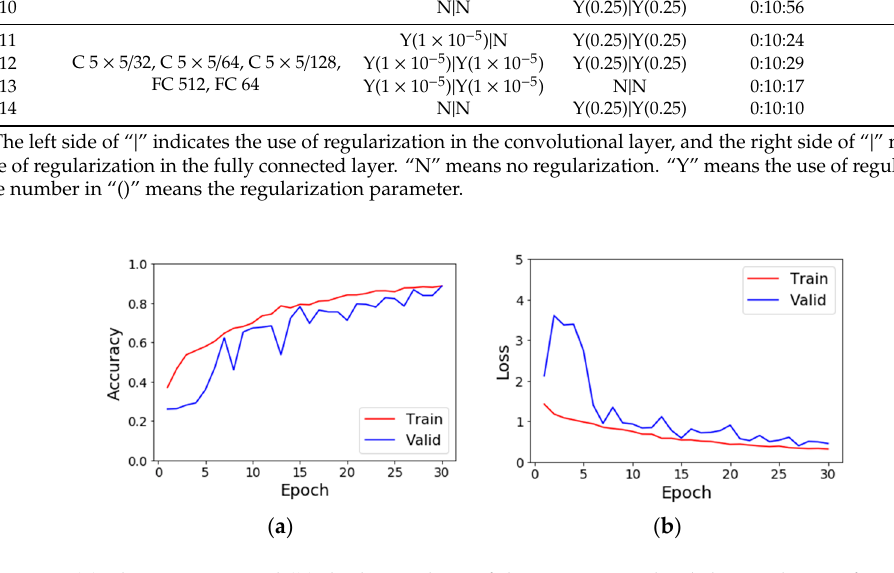
Figure 5. ( a ) The accuracy and ( b ) the loss values of the training and validation dataset for Model 11 using data augmentation, L2 regularization, and dropout.